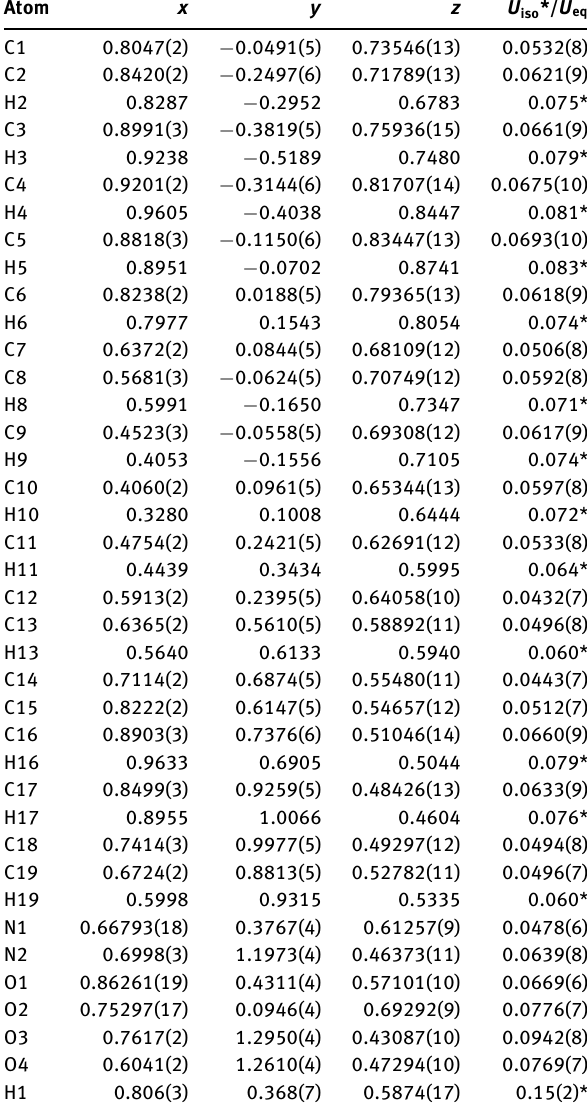
Table 2: Fractional atomic coordinates and isotropic or equivalent isotropic displacement parameters (Å 2 ).